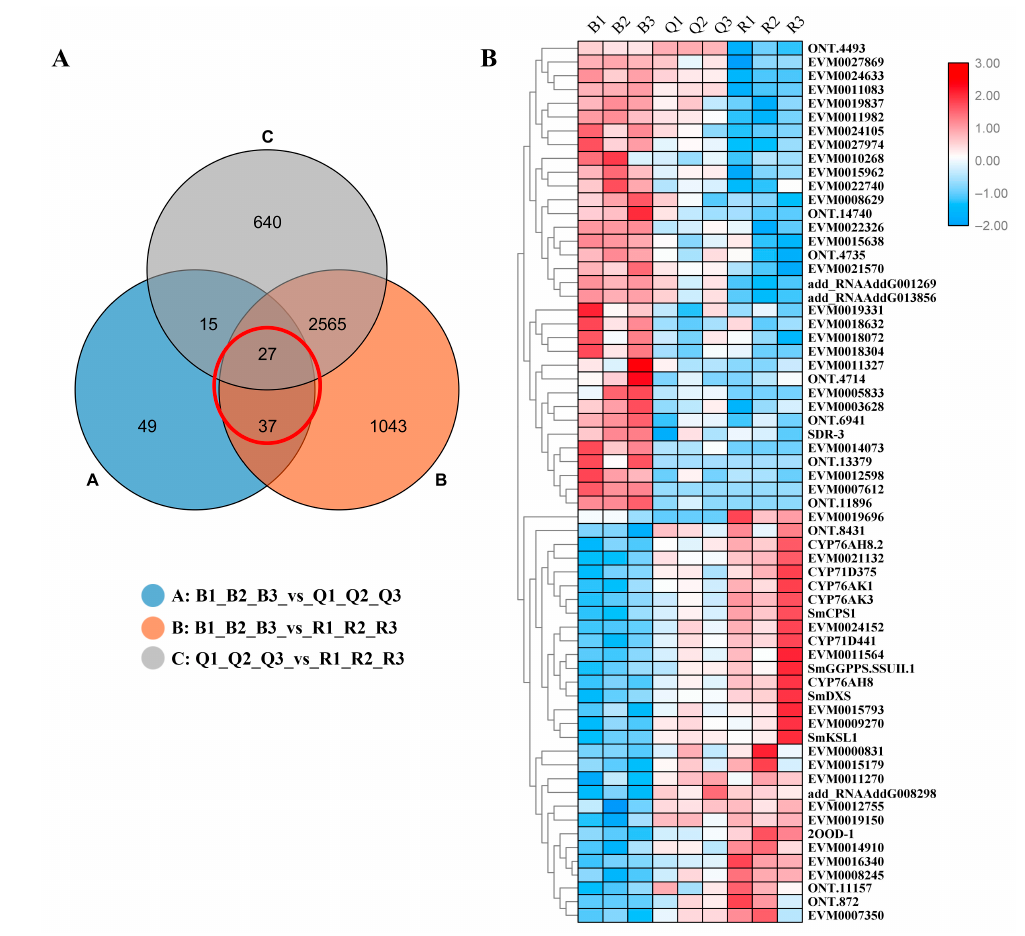
Figure 4. ( A ) Venn diagram of differentially expressed genes. Each circle in the figure represented a differential group, and the intersection of circles represented common differentially expressed genes. The corresponding number of genes was shown in the set. The adjacent genes have similar expression patterns in the ( B ) cluster diagram of 64 DEGs.